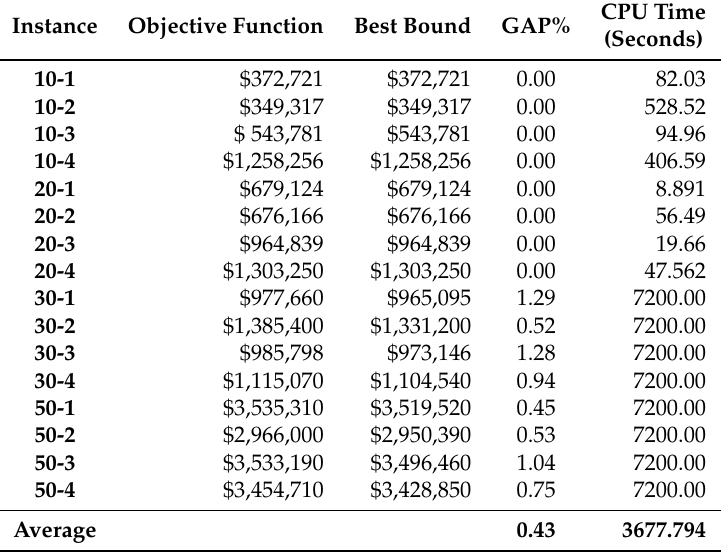
Table 6. Performance of the AS model over the test random